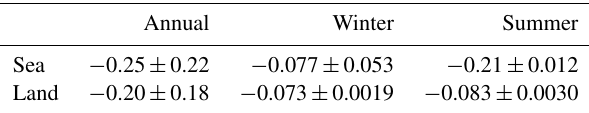
Table 5. Predicted direct radiative effect (Wm − 2 ) by SSA for the past